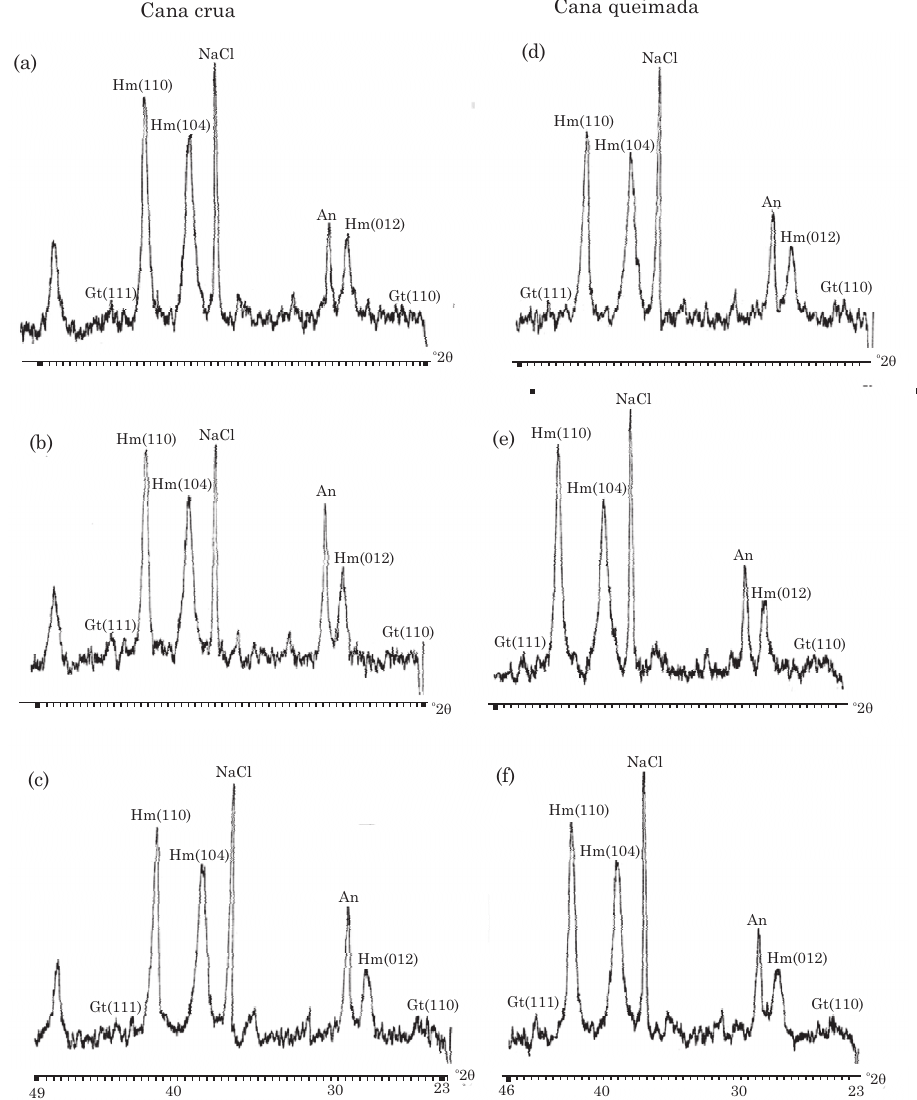
Figura 2. Difratogramas dos óxidos de ferro presentes na fração argila de Latossolo Vermelho eutroférrico, textura muito argilosa (LVef - Oxissol) obtidos no intervalo de 23 a 49 o 2 θθθθθ para seis amostras de